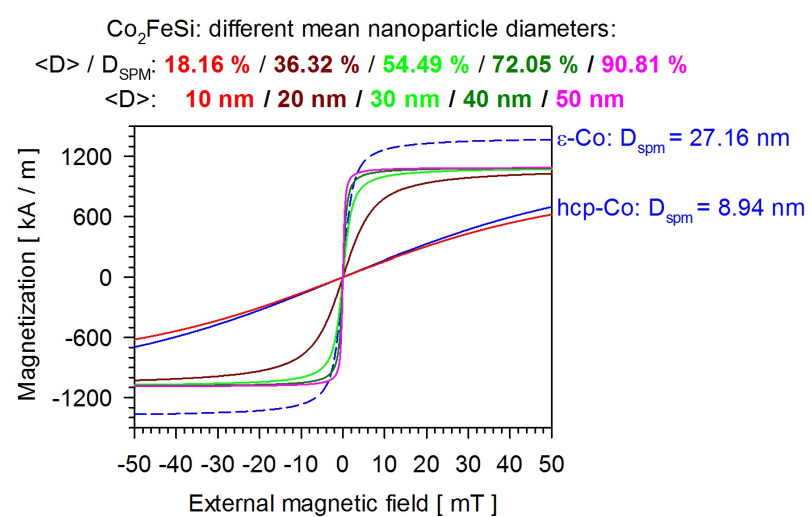
Figure 5. Calculated magnetization reversals of superparamagnetic nanoparticles of di ff erent